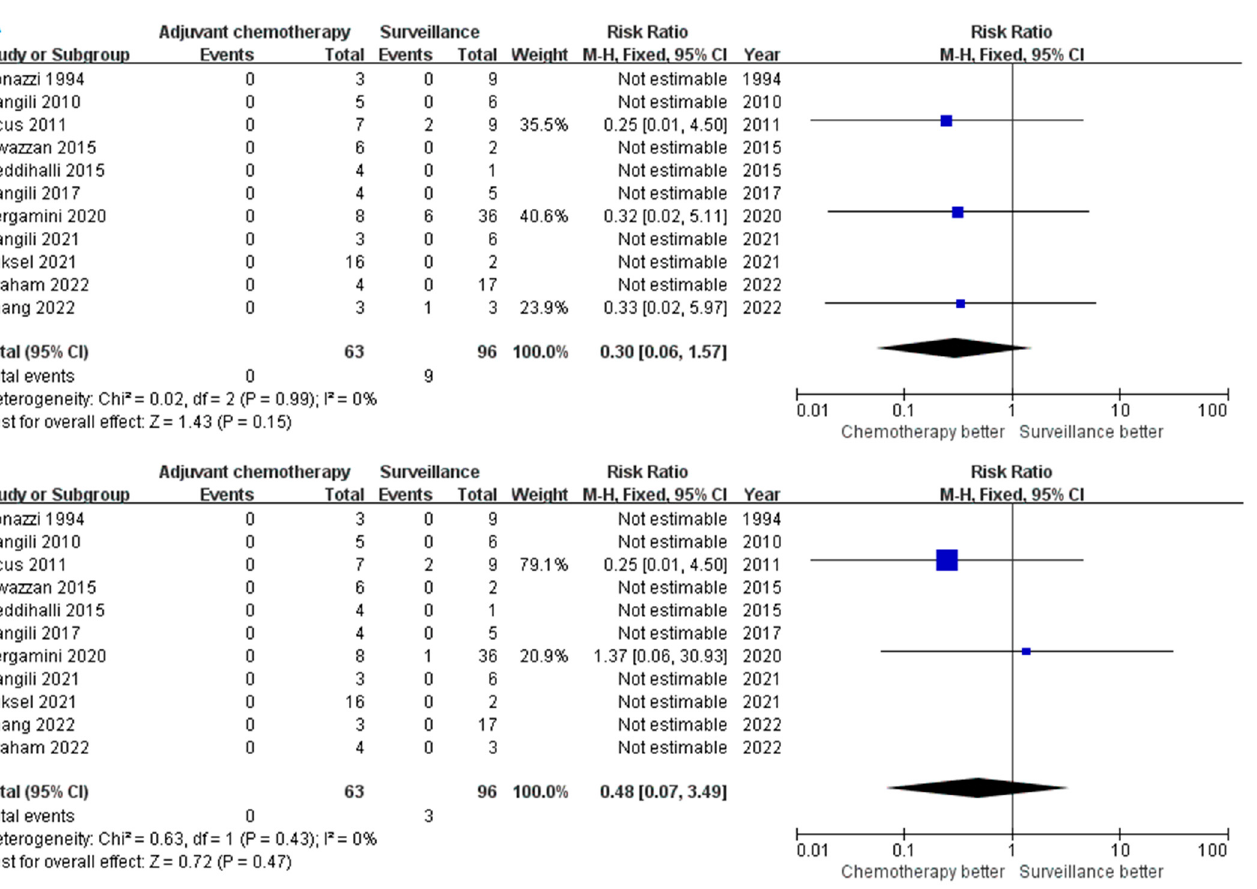
Figure 3. The forest plot revealed no significant difference between the stage IA G2-G3 POIT patients who received adjuvant chemotherapy or surveillance in recurrence ( A ) or mortality ( B ).